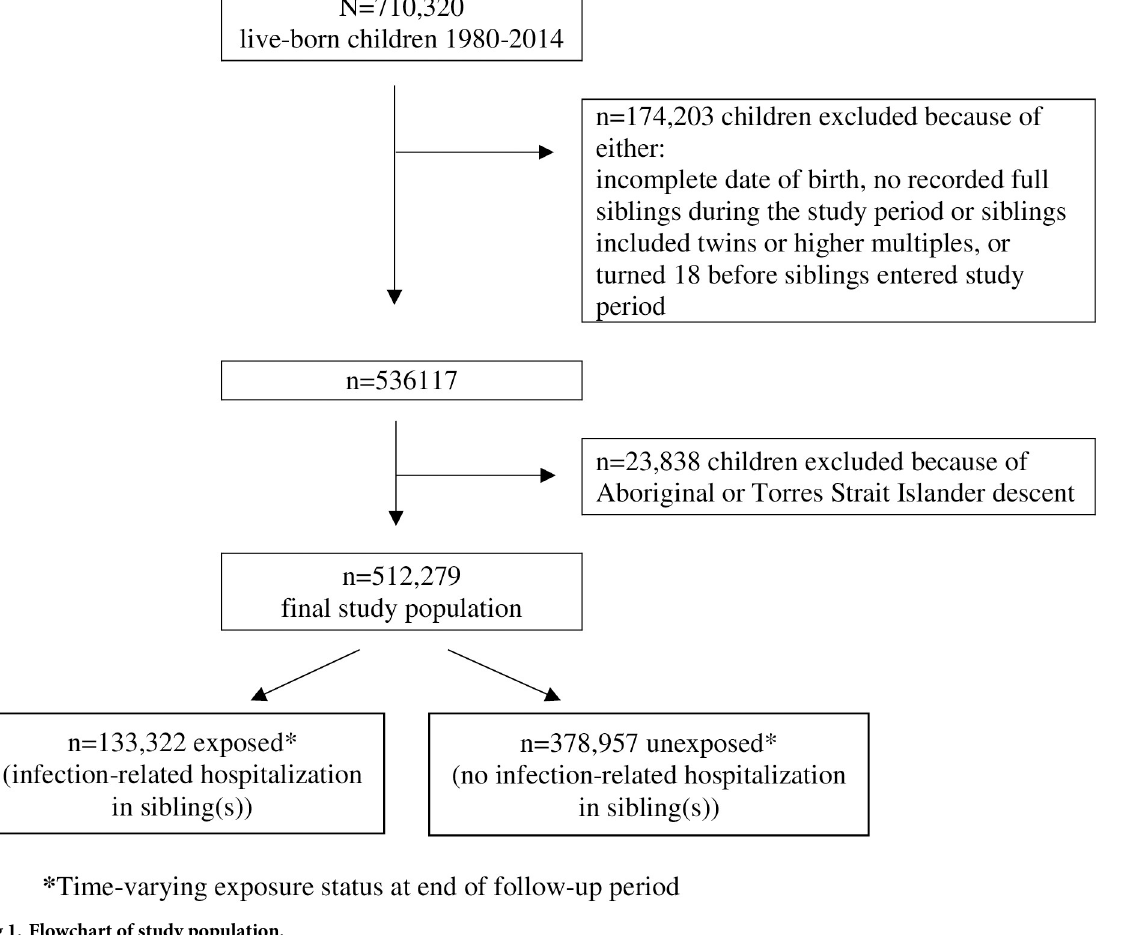
Fig 1. Flowchart of study